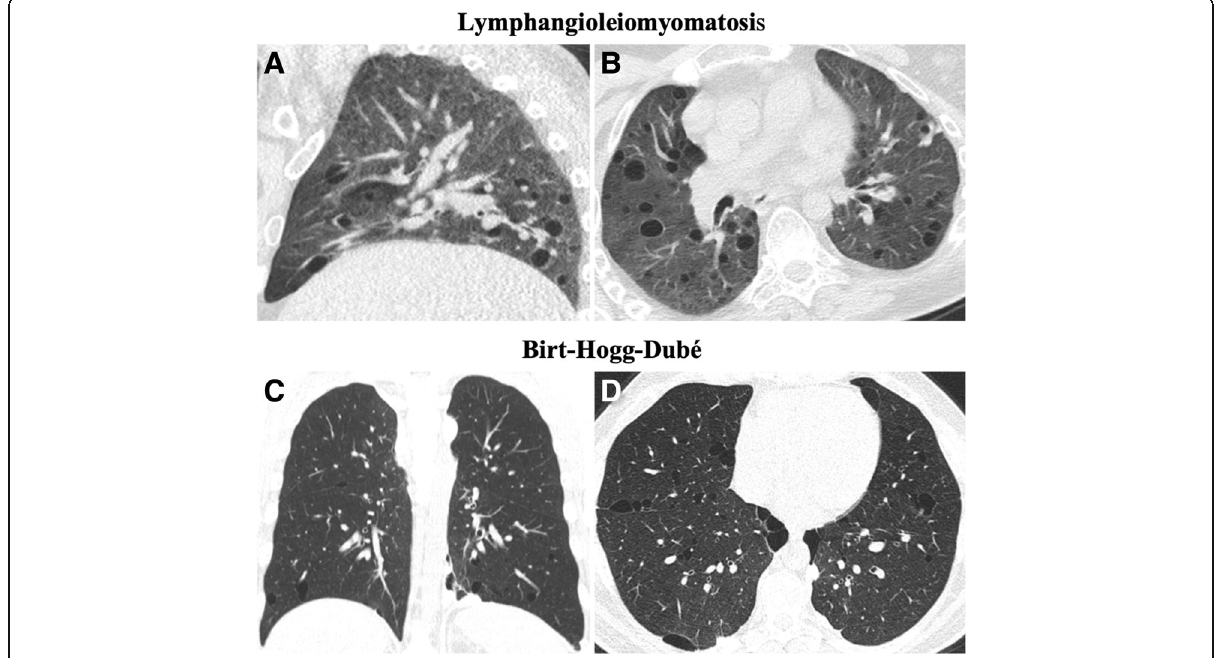
Fig. 14 Differential diagnosis of PLCH. a Sagittal and b axial CT images show a 50-year-old woman with LAM. There are multiple rounded-shaped cysts, with a relatively uniform distribution with no zonal predilection and affecting the lung bases. c Coronal and d axial CT images depict multiple cysts with a lower zone distribution, in a 35-year-old male with Birt-Hogg-Dubé syndrome. The patient had a history of recurrent